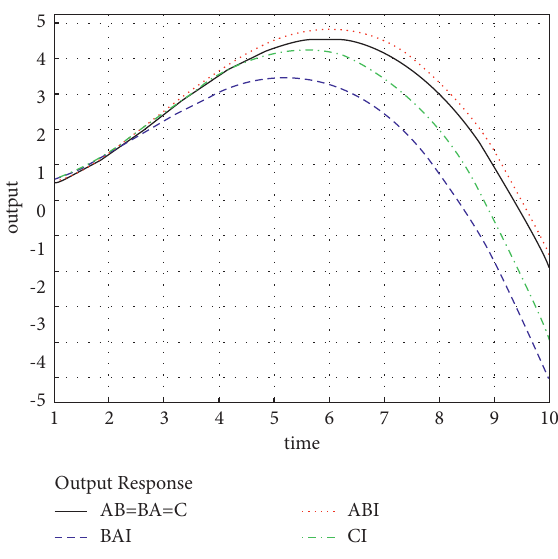
Figure 2: Simulation results of example 1.